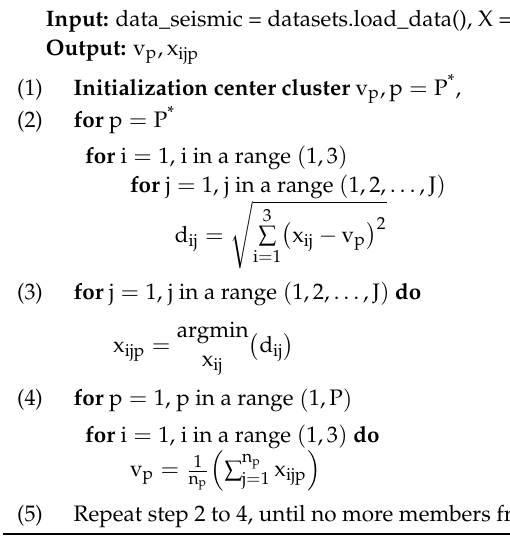
Algorithm 2. Pseudo code of K-Means